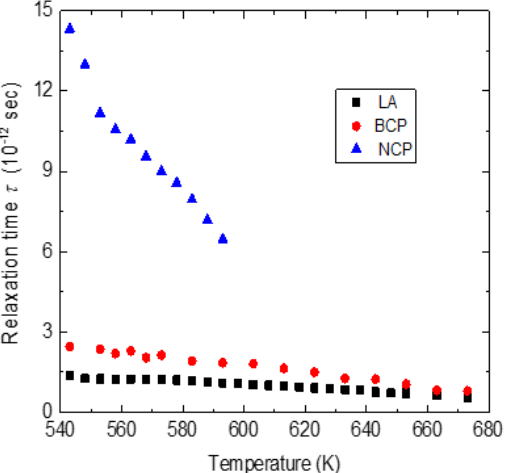
Figure 14. ( a – d )Broad central peak of 0.65PIN-0.35PT at ( a ) 633 K, ( b ) 593 K, ( c ) 573 K and ( d ) 463 K.